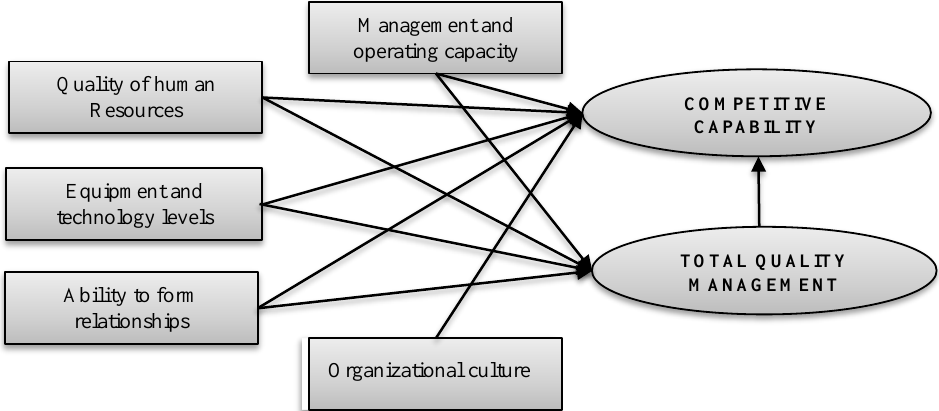
Figure 1. The research model for the factors affecting total quality management and competitive capability